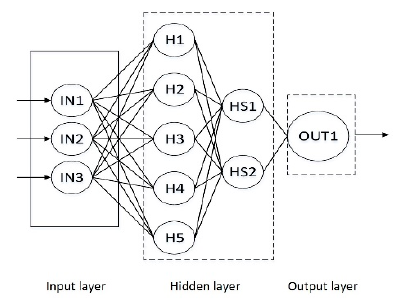
Figure 2. Topology of the neural network.